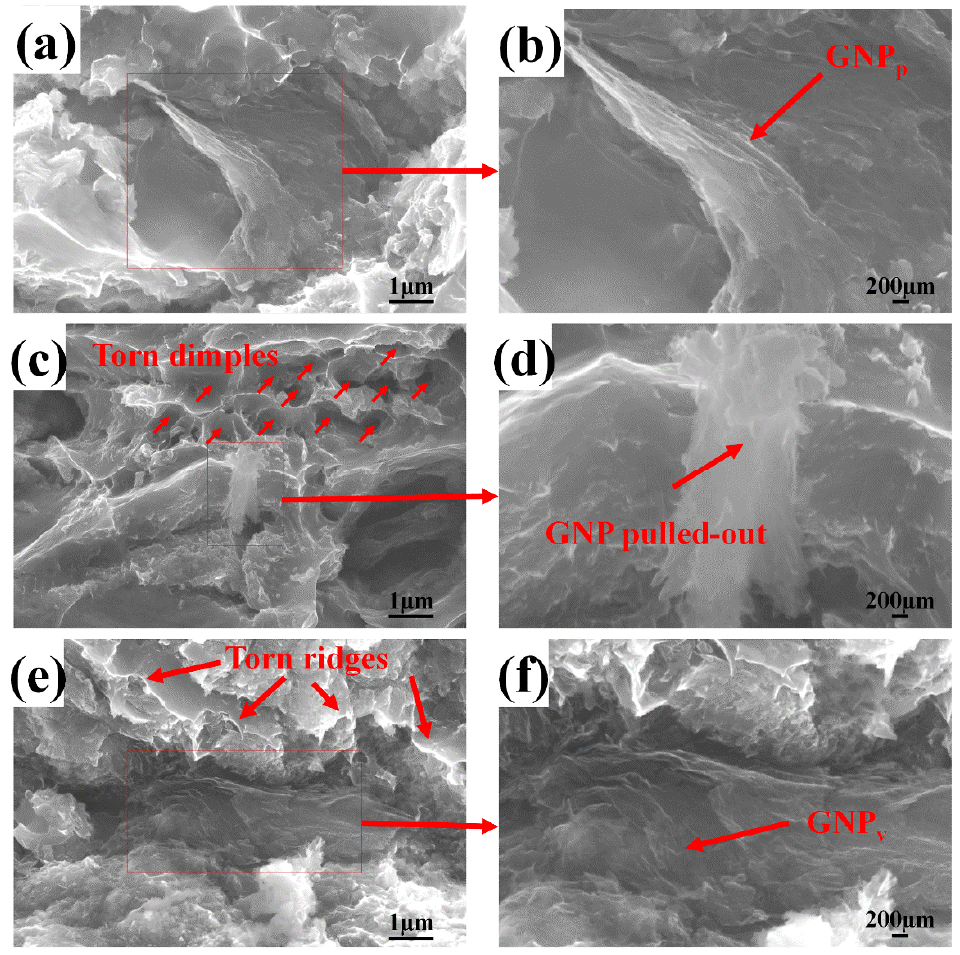
Figure 17. GNP on the tensile fracture surface of the composite. ( a ), ( b ) Parallel GNP; ( c ), ( d ) pulled-out GNP; ( e ), ( f ) vertical GNP.